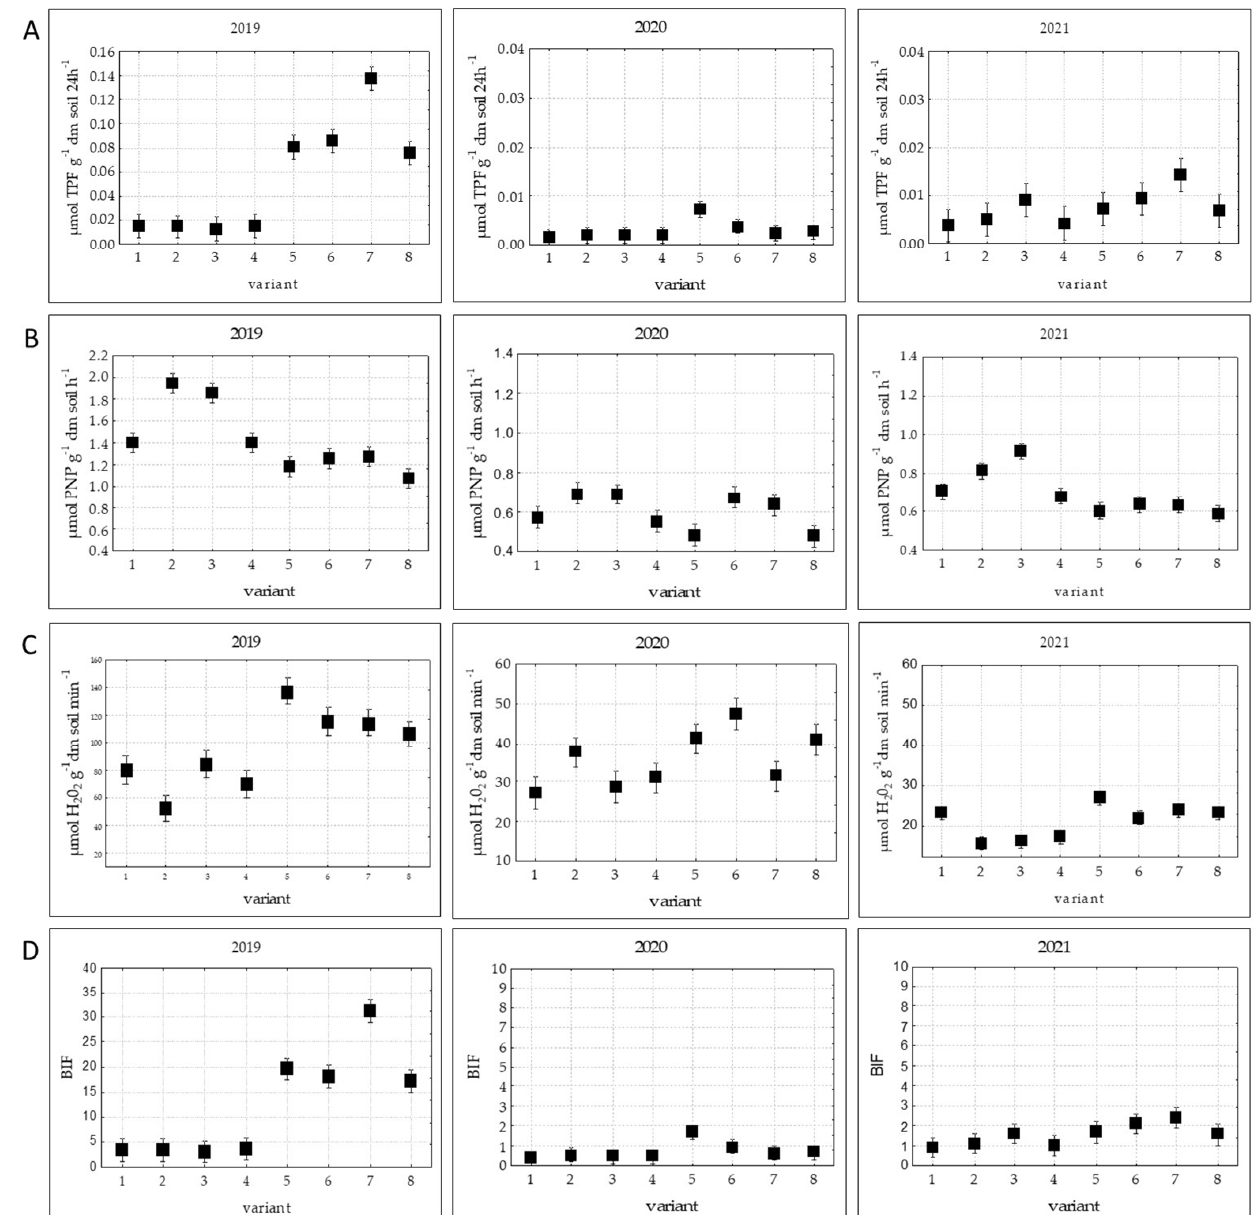
Figure 2. Biochemical activity in particular variants of the experiment. A —dehydrogenase activity (DHA), B —acid phosphatase (PAC), C —catalase activity (CAT), D —biological index fertility (BIF); 1—control variant (without undersown crops, without PGPR), 2—red clover catch crop, 3—red clover and Italian ryegrass catch crop, 4—Italian ryegrass catch crop, 5—control variant (without undersown catch crops) + PGPR, 6—red clover catch crop + PGPR, 7—red clover catch crop + Italian ryegrass + PGPR, 8—Italian ryegrass catch crop + PGPR.